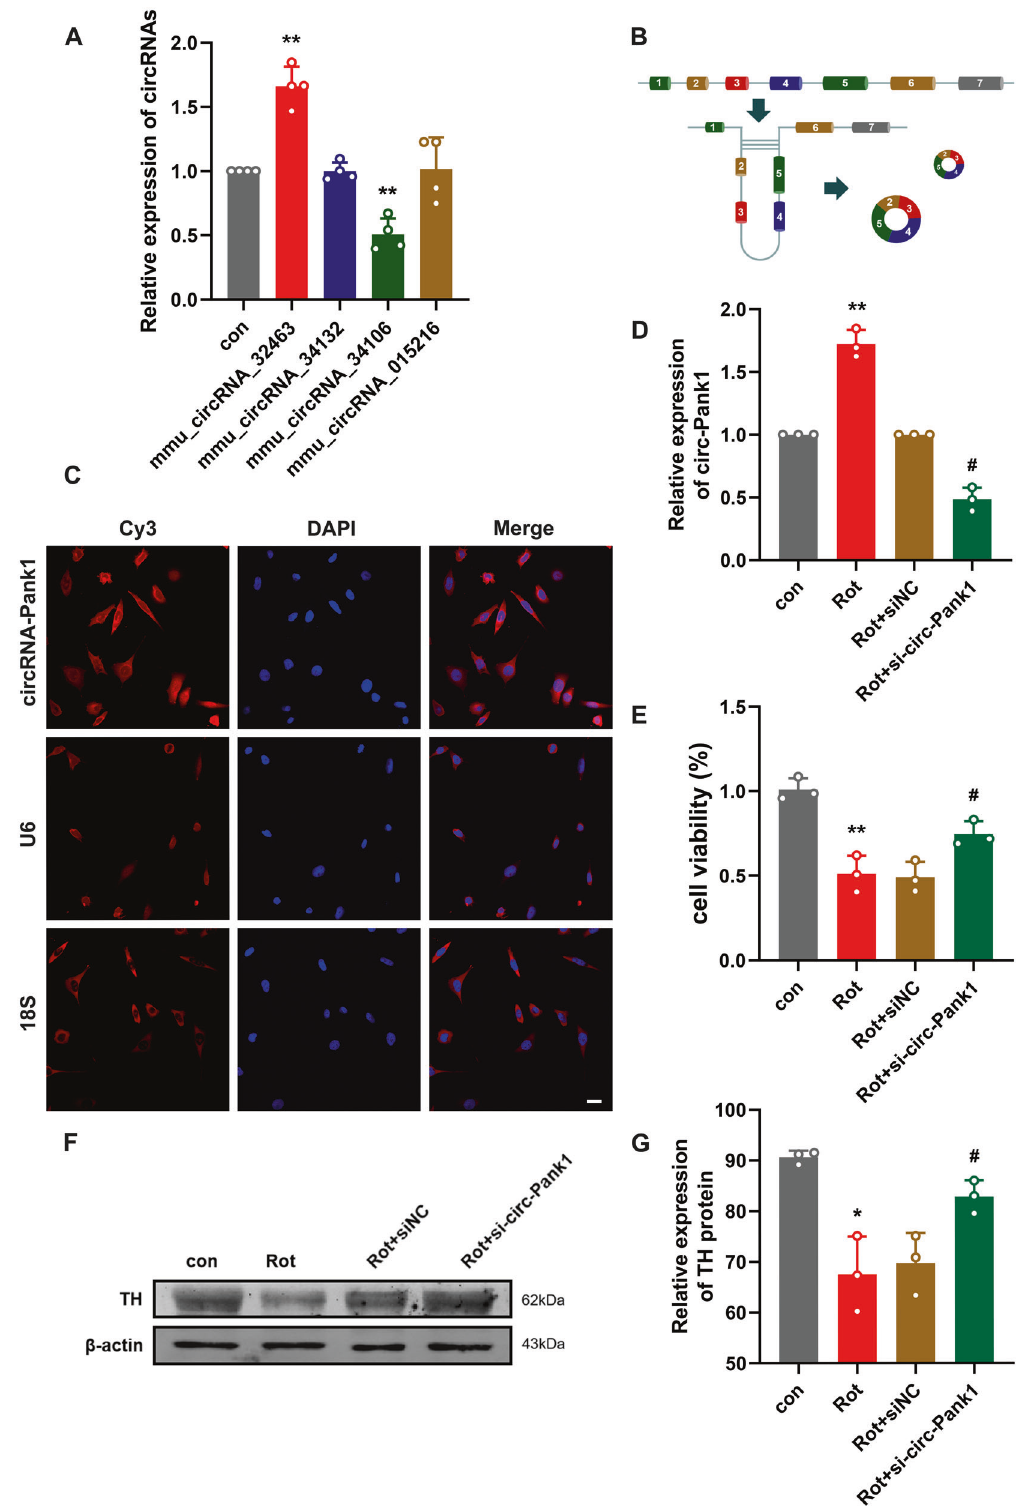
Fig. 2 The expression of circ-Pank1 signi fi cantly increased in PD model mice treated with rotenone and downregulation of circ-Pank1 in the MN9D cell model alleviates the damage to dopaminergic neurons. A qRT – PCR was used to detect the expression of mmu_circ_32463, mmu_circ_34132, mmu_circ_34106, and mmu_circ_015216 in the SN of PD model mice treated with rotenone ( n = 4). B Schematic diagram of ring formation of circ-Pank1. C Sublocalization of circ-Pank1 in MN9D cell. Taking U6 in the nucleus and 18S in the cytoplasm as the controls, most circ-Pank1 in MN9D cells was located in the cytoplasm; scale bars, 50 μ m. D – G After si-circ-Pank1 and the corresponding control were transferred into the MN9D cell model treated with rotenone ( n = 3). D qRT – PCR was used to detect the expression of circ-Pank1. E CCK-8 was used to detect the cell viability. F , G Western blot analysis of the TH protein levels. Data are presented as mean ± SD. * P < 0.05, ** P < 0.01.